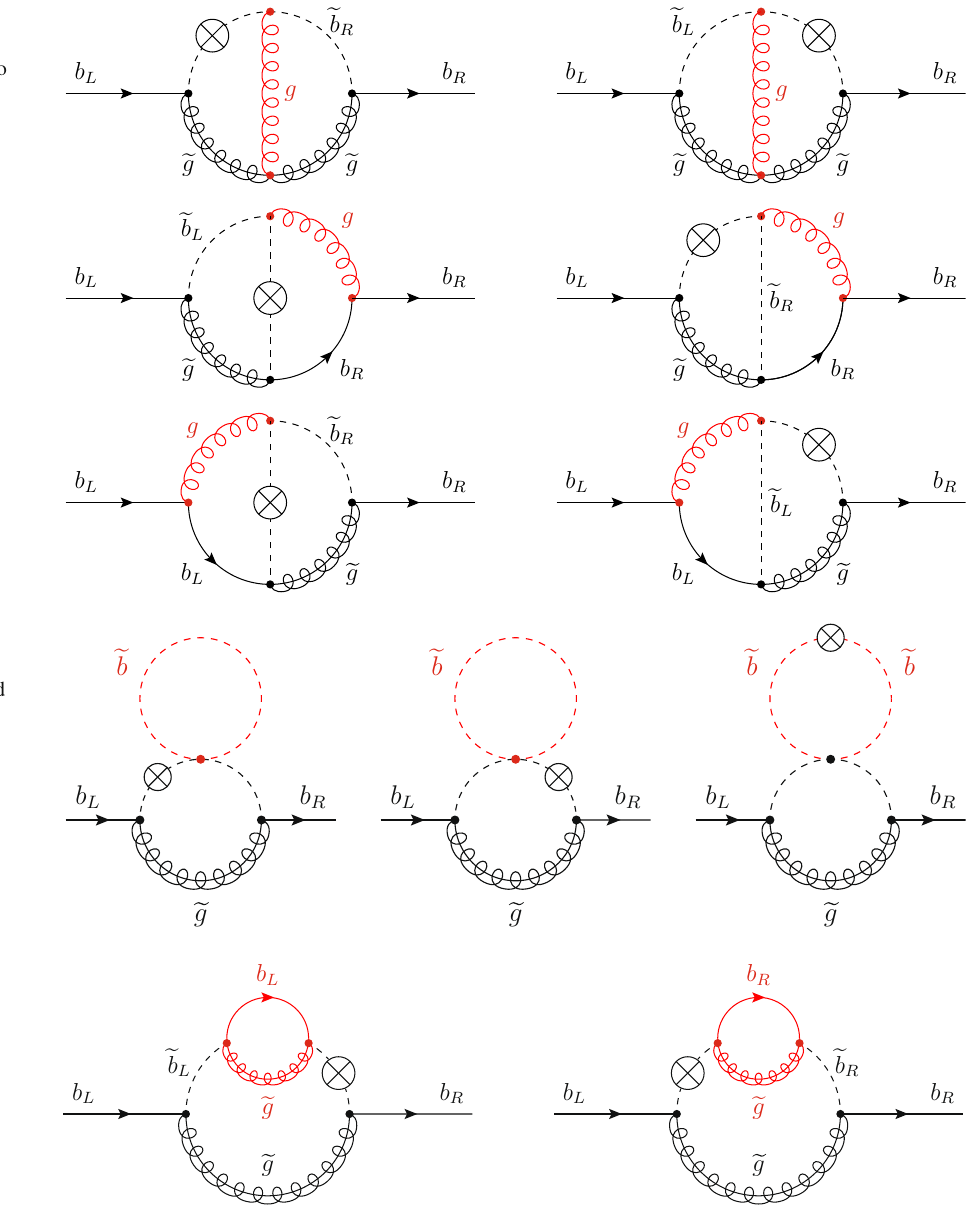
Fig. 13 The third class of two-loop diagrams